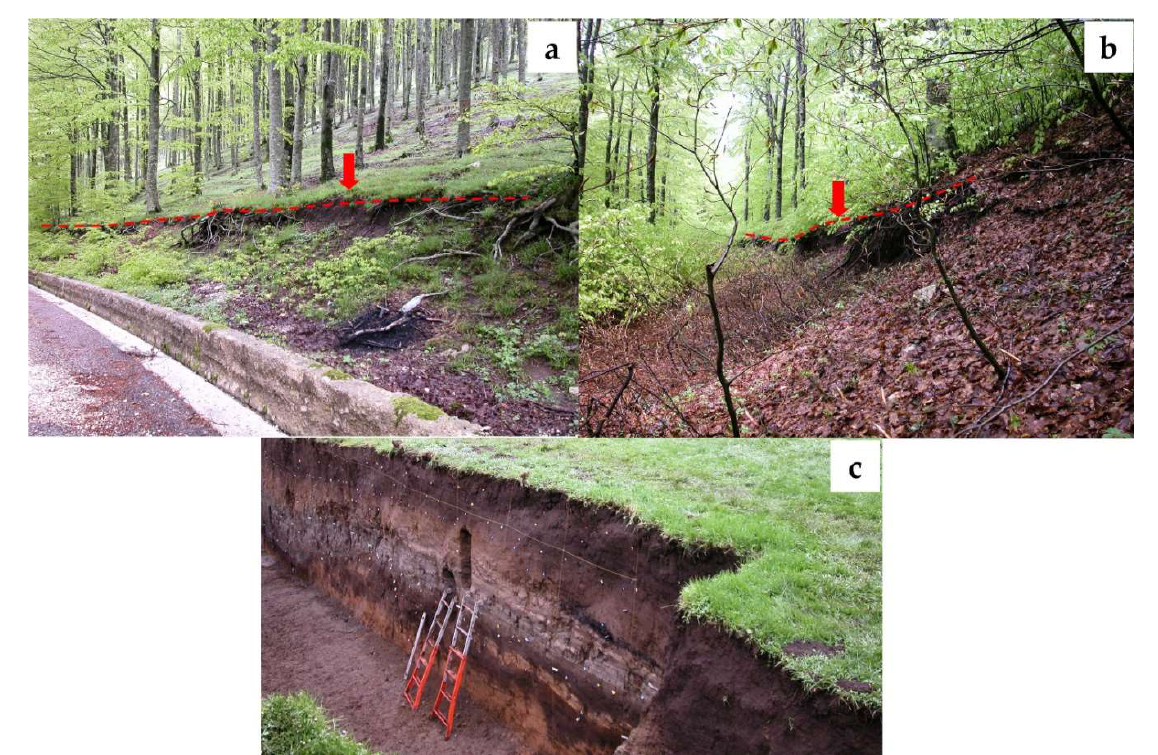
Figure 2. The photos ( a , b ), taken in 2004, show the coseismic 1980 fault scarps along M.te Carpineta; the photo ( c ) shows a paleoseismological trench wall along the Piano di Pecore plain (Photos by Rosa Nappi).